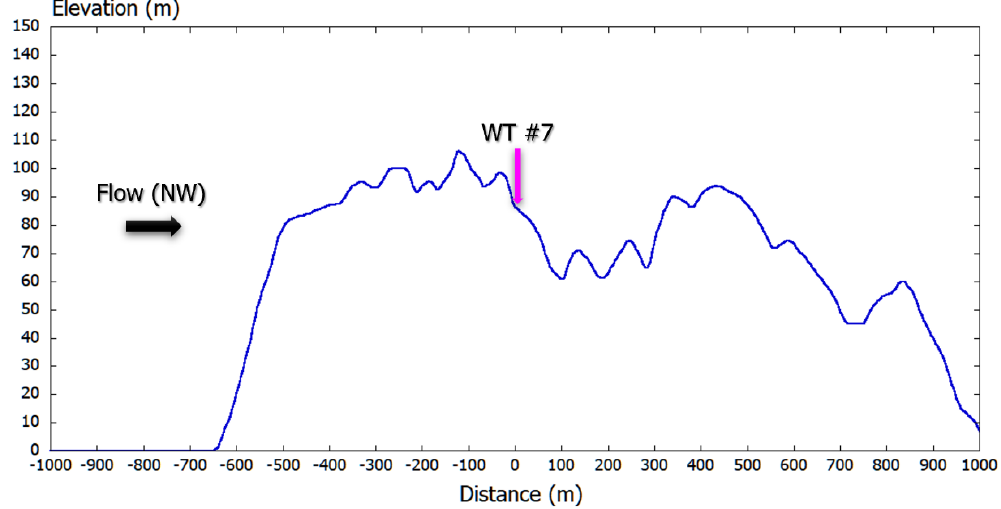
Figure 21. Terrain shapes passing through WT #7 for north-westerly wind.